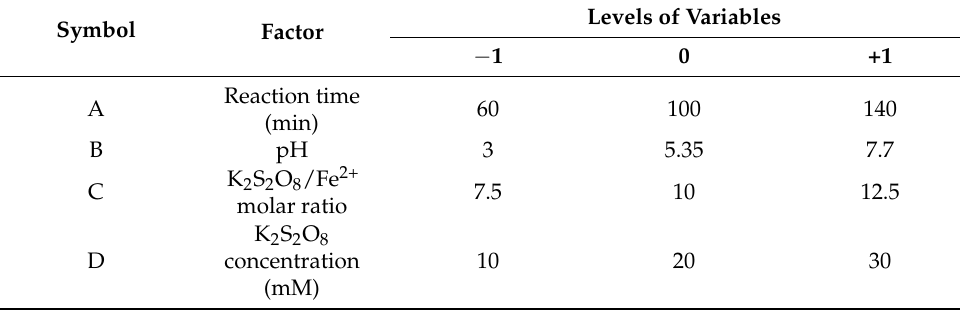
Table 5. Independent variables and their